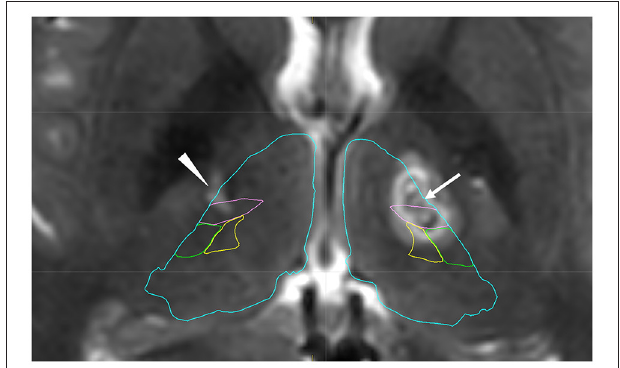
FIGURE 1 | Postoperative T2-weighted image after left thalamotomy with anatomical mapping by Brainlab Elements. The arrow shows coagulated lesions in the left ventro-oral (Vo) nucleus. Posterior coagulated lesions are located in the ventral intermediate nucleus (Vim). The arrowhead shows an old lesion after previous surgery, which was confirmed in the Vo and Vim nucleus. Blue: thalamus, Pink: Vim, Green: ventral posterior lateral nucleus, Yellow: ventral posterior medial